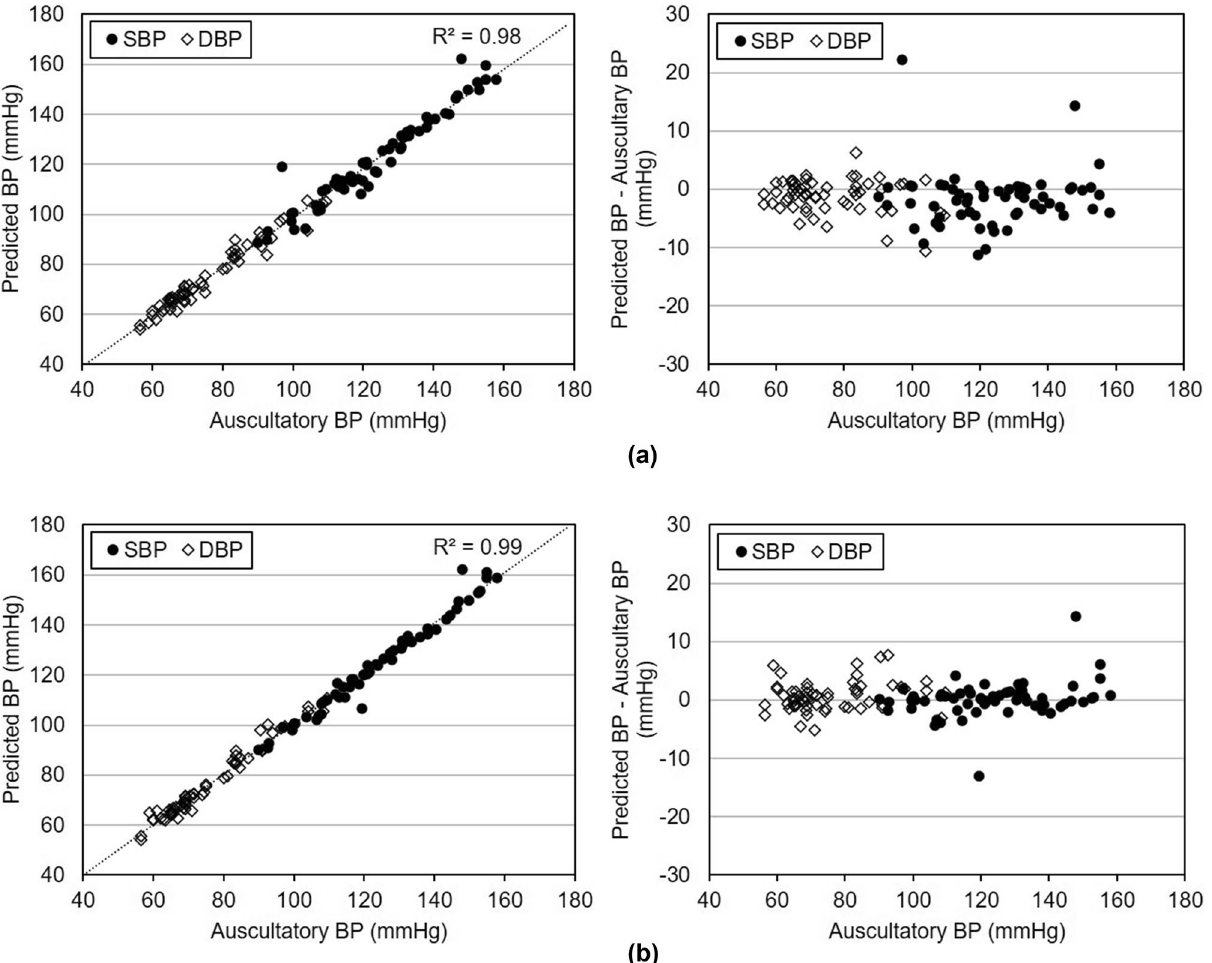
Figure 9. Predicted SBP and DBP: ( a ) baseline method; ( b ) proposed method.